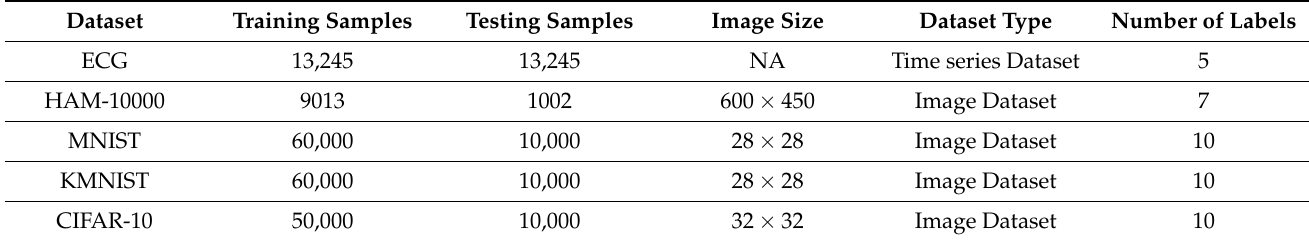
Table 1. Datasets used in our experiment setup.